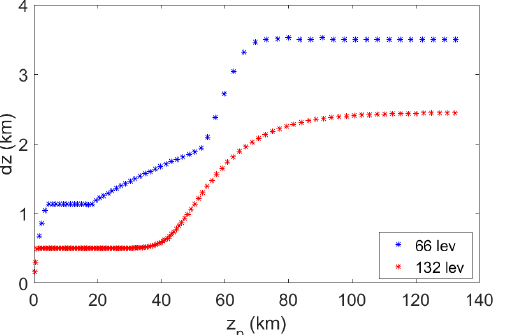
Figure 1. Vertical resolution. The plot shows the difference in distribution of levels bettwen the standard 66-level version (blue) and the high vertical resolution version with 132 levels